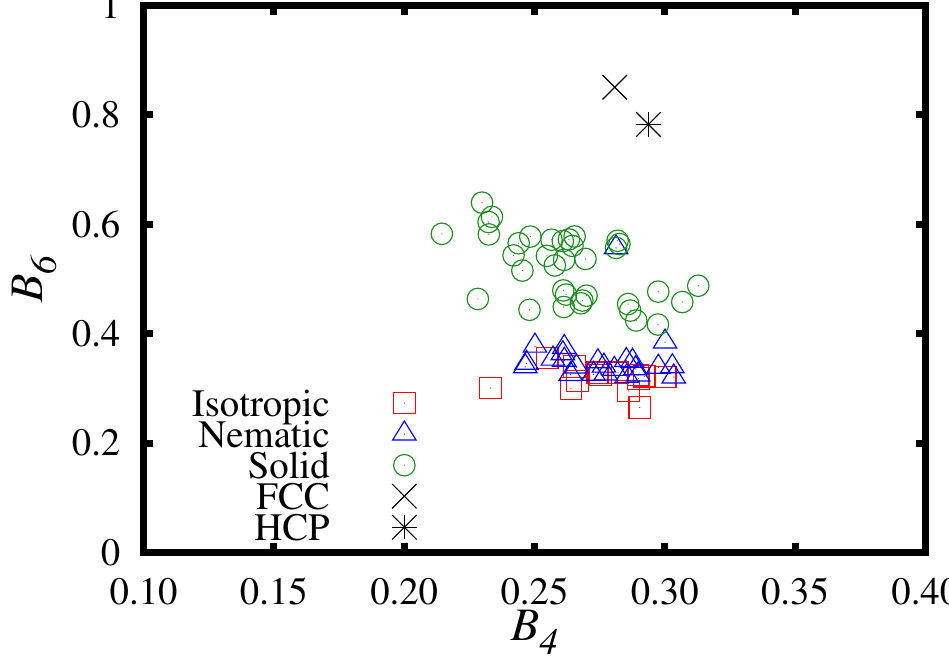
Figure 10. A plot of B 4 versus B 6 for the Hess–Su liquid-crystal model studied in this work using the upward branch of the replica-exchange method simulations. The phase of each point is denoted in the legend. For comparison, data points for perfect FCC and HCP crystals are also